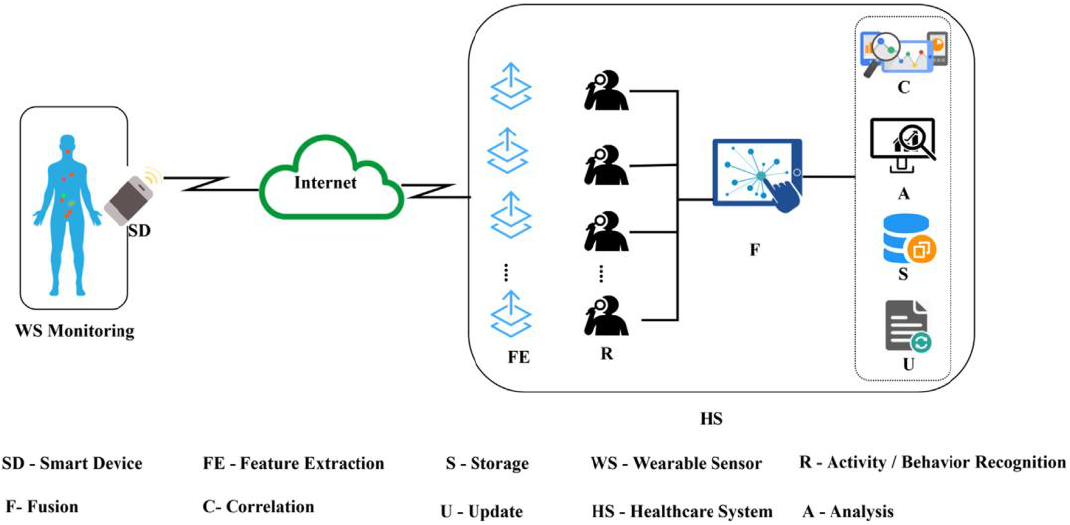
Figure 7. WS to the health care system has been taken from [84].